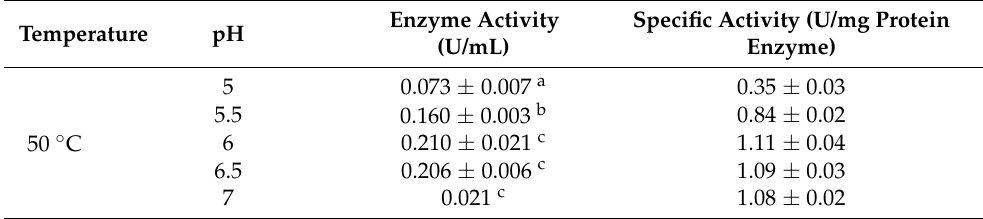
Table 2. Bromelain enzyme activity at various pH